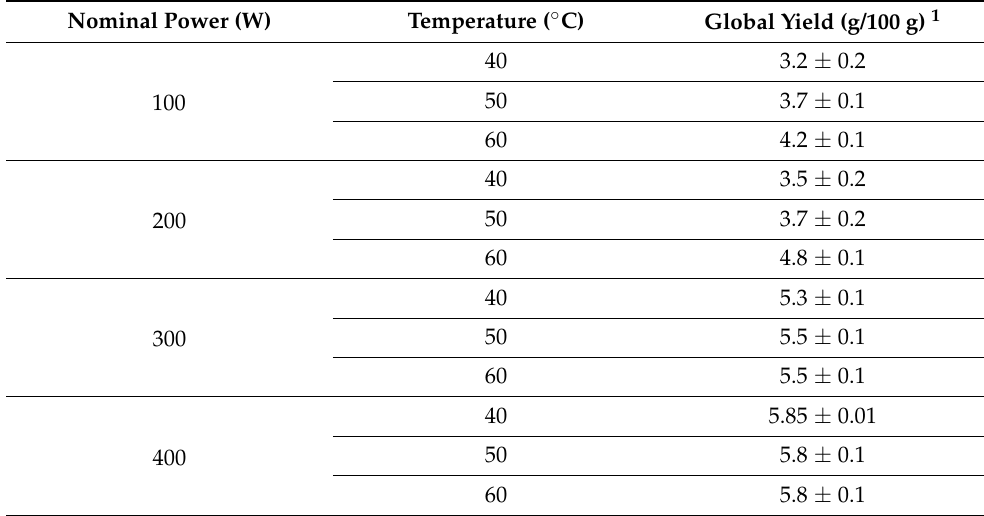
Table 1. Thermosonication extraction